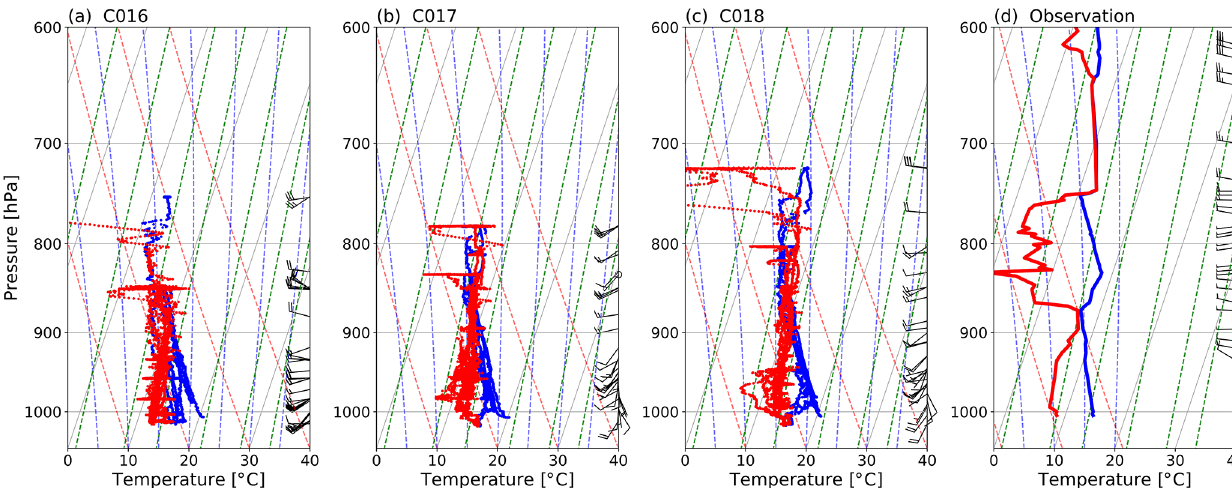
Figure 2. Skew-T log-P plots showing (a–c) temperature (blue) and dew point temperature (red) for all three flights and (d) temperature and potential temperature from a radiosonde launched from Nottingham at 00:00UTC on 4 July 2017.